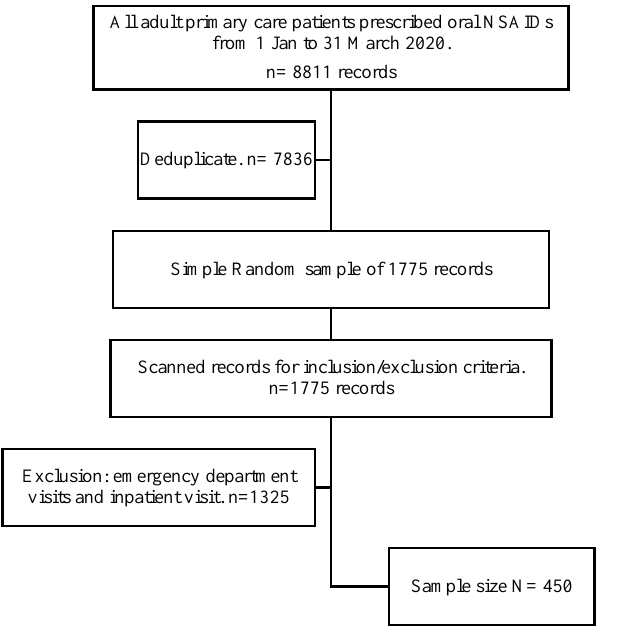
Figure 1. Retrospective chart review study flowchart. NSAIDs, non-steroidal anti-inflammatory drugs.